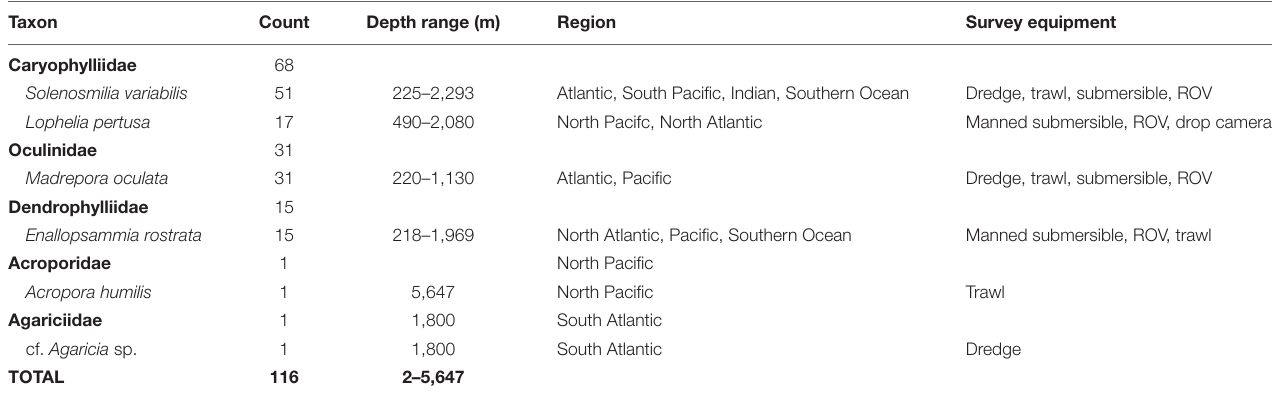
TABLE 2 | Counts by taxonomic groups for the reef-building coral records in marine areas beyond national jurisdiction examined as part of this